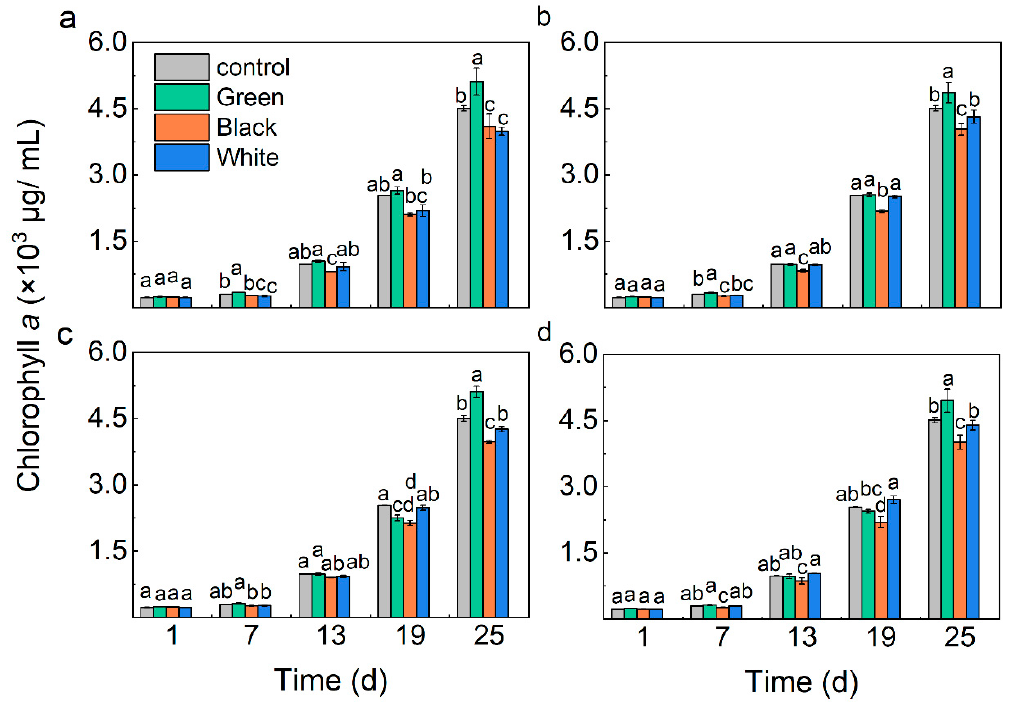
Figure 2. The chlorophyll a content dynamics of M. aeruginosa after being exposed to different color and concentration mPET (( a ): 10 mg/L; ( b ):50 mg/L; ( c ): 100mg/L; ( d ): 200 mg/L). All the values are means ± S.D. Identical letters denote no significant difference ( p < 0.05).